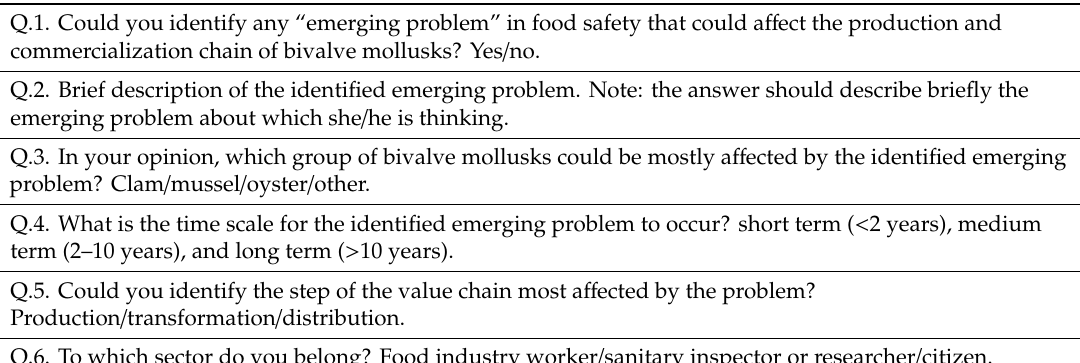
Table 2. Questions in the online inquiry formulated by RISEGAL.